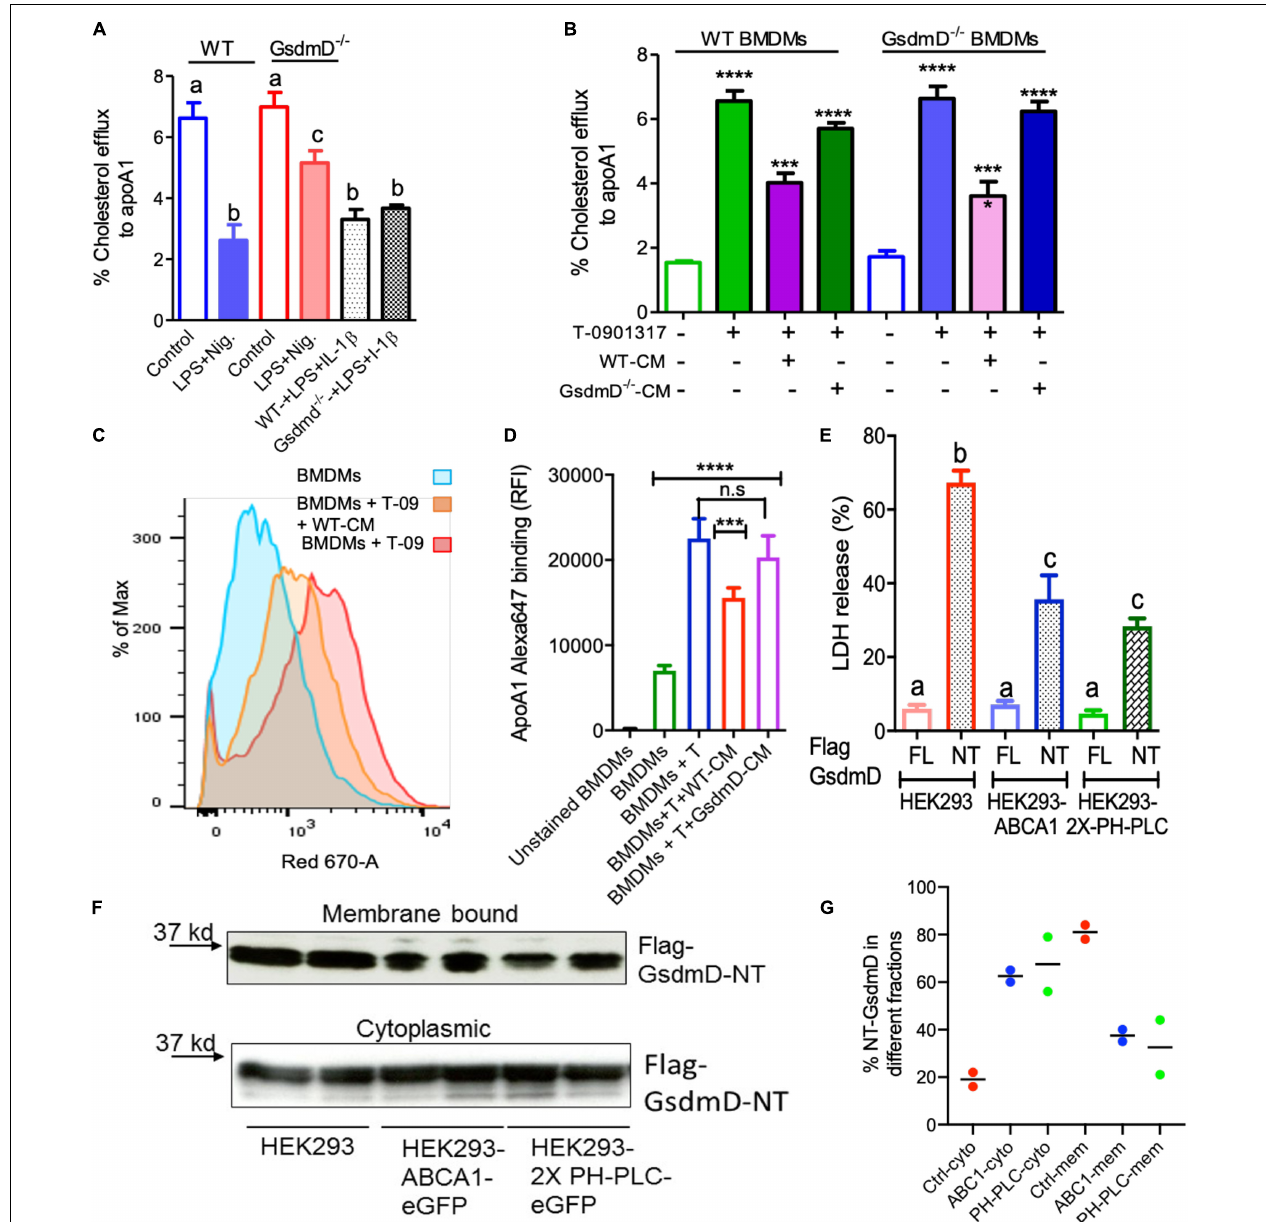
FIGURE 2 | Gasdermin D (GsdmD) promotes Nlrp3 inflammasome-mediated defects in reverse cholesterol transport. (A) BMDMs isolated from WT or GsdmD - / - mice were loaded with 3 H-cholesterol +50 µ g/ml AcLDL for 24 h and treated with LXR-agonist T0901317 (Sigma-Aldrich) to induce ABCA1 expression. The Nlrp3 inflammasome was induced by LPS + Nigericin treatment, followed by cholesterol efflux assay using lipid-free apoA1 (5 µ g/ml) in serum-free DMEM as chase media for 4 h at 37 ◦ C. Values are % cholesterol efflux (mean ± SD, N = 4, different letters represent p < 0.01 by ANOVA Bonferroni post-test). (B) The BMDMs isolated from WT or GsdmD - / - mice were loaded with 3 H-cholesterol +50 µ g/ml AcLDL for 24 h. The BMDMs, ± LXR-agonist T0901317, were treated with conditioned media isolated from LPS + ATP treated WT or GsdmD - / - BMDMs for 16 h. The cholesterol efflux assay was performed using lipid-free apoA1 (5 µ g/ml) in serum-free DMEM as chase media for 4 h at 37 ◦ C. Values are % cholesterol efflux (mean ± SD, N = 4, **** represent p < 0.0001, *** represent p < 0.001 by ANOVA Bonferroni post-test). (C) The flow cytometry analysis showing histogram bar for Alexa-647 labeled apoA1 binding to cells, ± ABCA1 expression and ± WT conditioned media treatment. (D) The flow cytometry analysis showing quantification of Alexa-647 labeled apoA1 binding to cells ± ABCA1 expression and ± . WT or GsdmD - / - conditioned media treatment (mean ± SD, N = 4, **** represent p < 0.0001, *** represent p < 0.001 by ANOVA Bonferroni post-test). (E) The HEK293, HEK293-ABCA1-eGFP, or HEK293-2X-PH-PLC-eGFP cells were transfected with plasmids carrying either full-length (FL) GsdmD or N-terminal fragment (NT) of GsdmD. The LDH release in media is plotted in% values of total cellular LDH (mean ± SD, N = 4; different letters show p < 0.001, by ANOVA Bonferroni post-test). (F) The control HEK293 and HEK293 cells stably transfected with ABCA1 or PH-PLC were transfected with plasmid carrying Flag tagged GsdmD-NT. The transfected cells were fractionated into cytoplasmic or membrane bound fractions. The fractions were resolved using SDS gel, transferred to nitrocellulose membrane, and probed with antibody against Flag tag. (G) The % quantification of NT-GsdmD in the cytoplasmic and membrane fractions.